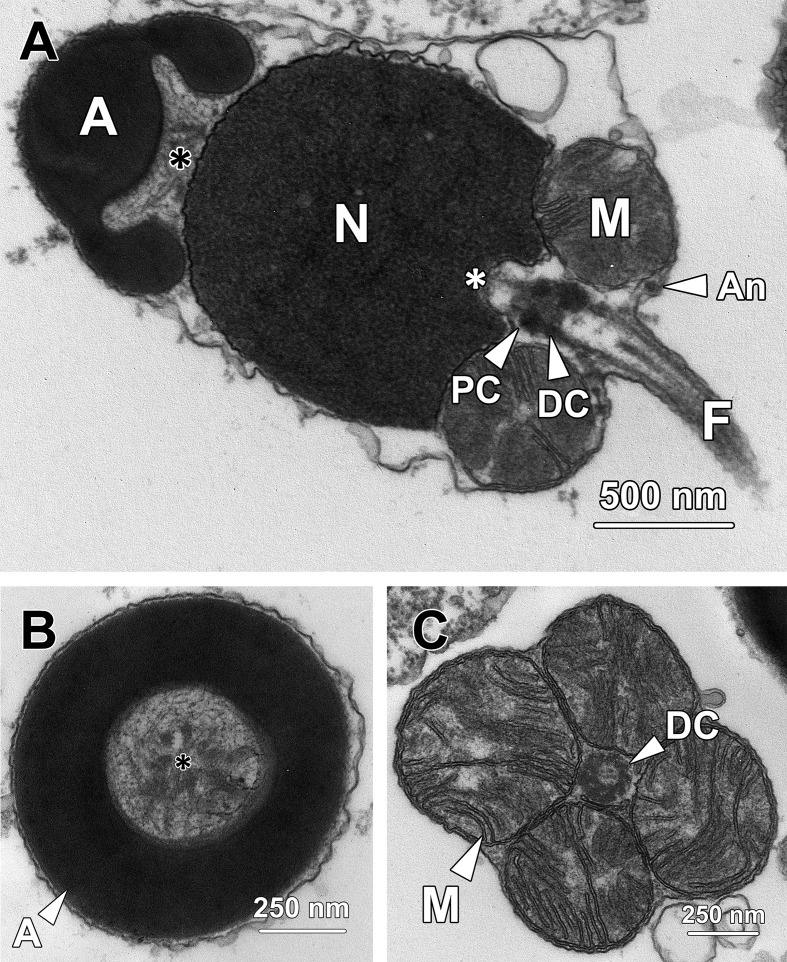
Transmission electron micrographs of spermatozoa.(A) Spermatozoa consist of a cap-like acrosome (A), an oval nucleus (N), a short midpiece containing four spherical mitochondria (M) and an elongated flagellum (F). A subacrosomal space (*, black asterisk) forms between the acrosome and the nucleus, containing evenly distributed electron-dense fibrillary subacrosomal material. The proximal centriole (PC) is inserted into the implantation fossa (*, white asterisk) formed at the posterior end of the nucleus. The four mitochondria lodge in concave recesses at the posterior nuclear margin and surround the base of the flagellum, where the annulus (An) forms. (B) A transverse section through the ring structure at the base of the acrosome shows the fibrillary content of the subacrosomal space (*, black asterisk). (C) A transverse section through the midpiece shows four spherical mitochondria (M) encircling the base of the flagellum.